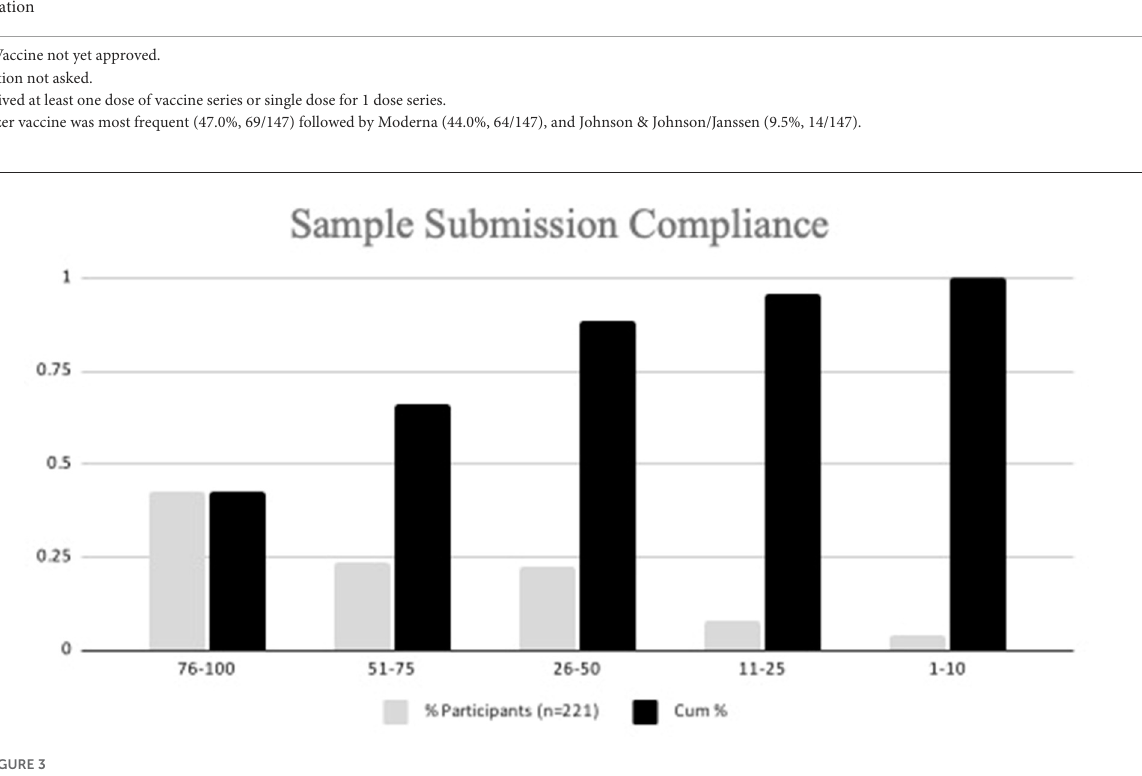
FIGURE3 Sample submissions among